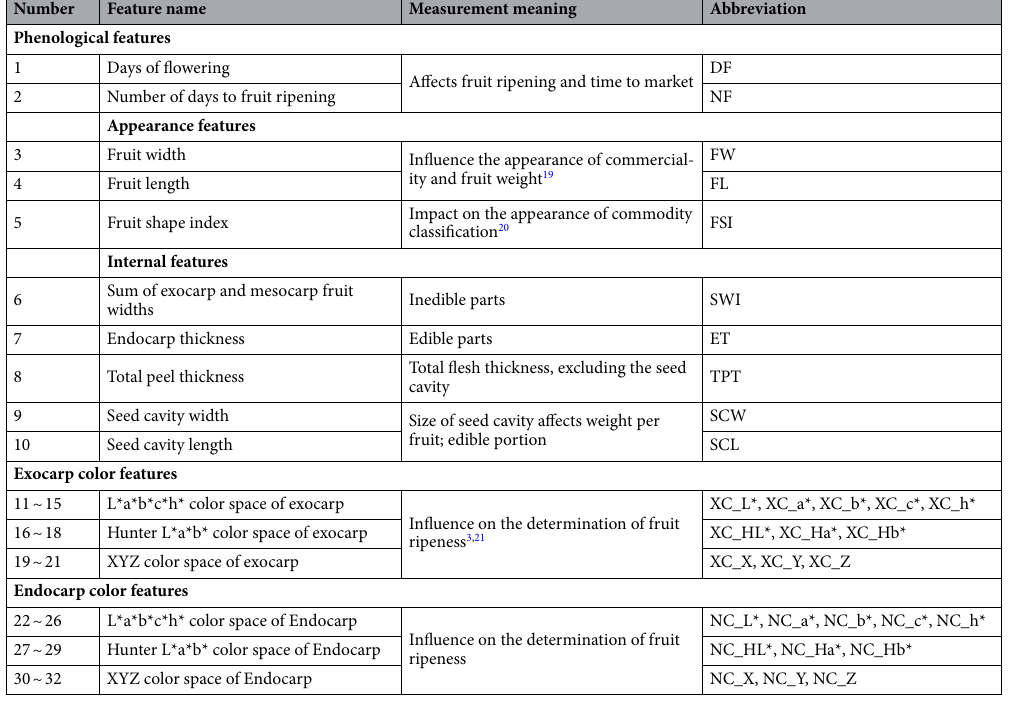
Table 1. Feature variable related